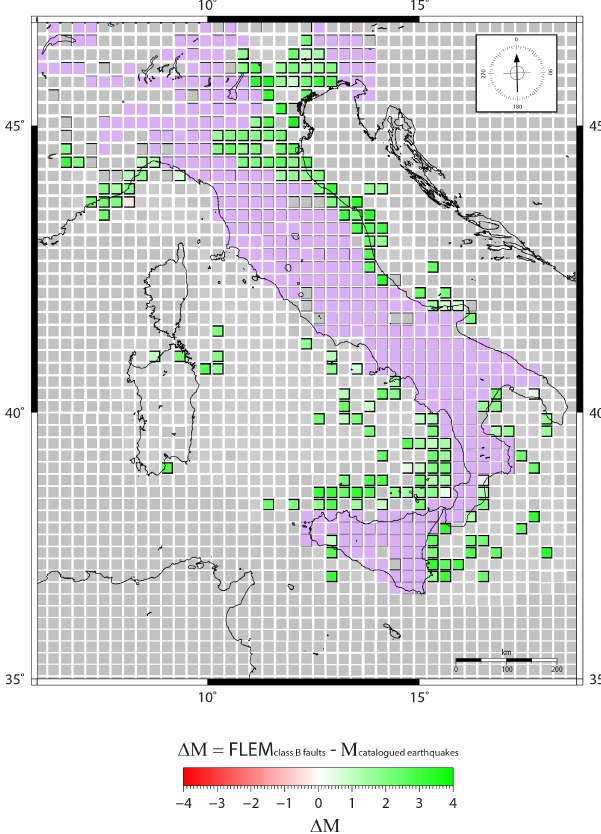
Figure 10. Map of the difference between FLEM values (only from class A faults; Fig. 7) and maximum magnitudes from historic or instrumental earthquakes (Fig. 9). Light grey is for cells with no data, whereas dark grey is for cells where the longest faults belong to the class B set. See Fig. 12 for the interpretation of red vs. green cells.